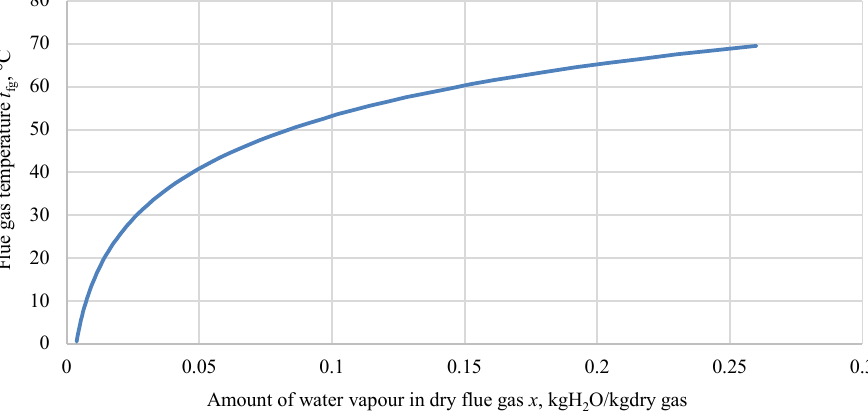
Fig. 1. Saturating amount of water vapour kg H2O /kg gas from 0 °C ... 70 °C at normal